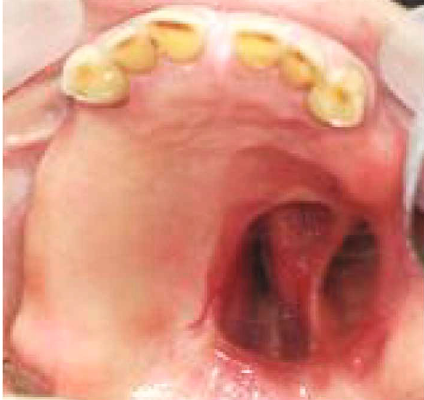
Figure 1: Maxillary defect was connecting the oral cavity to the left maxillary sinus and the nasal fossae.